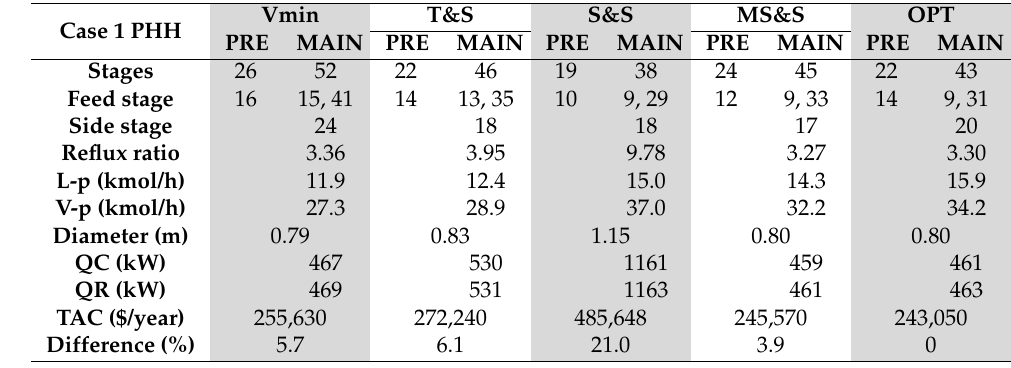
Table 3. Results for the n-Pentane, n-Hexane, and n-Heptane (PHH) mixture.